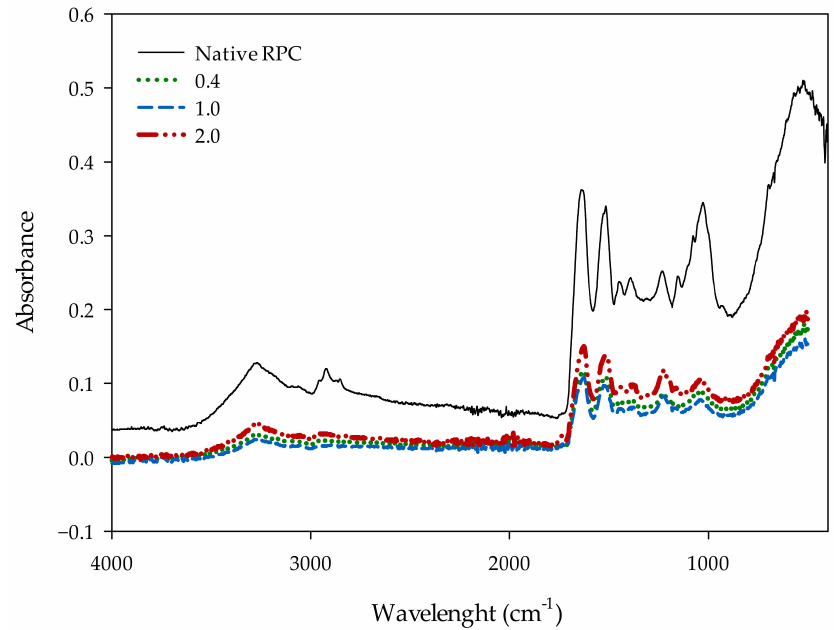
Figure 6. FTIR spectrum of the native and acetylated